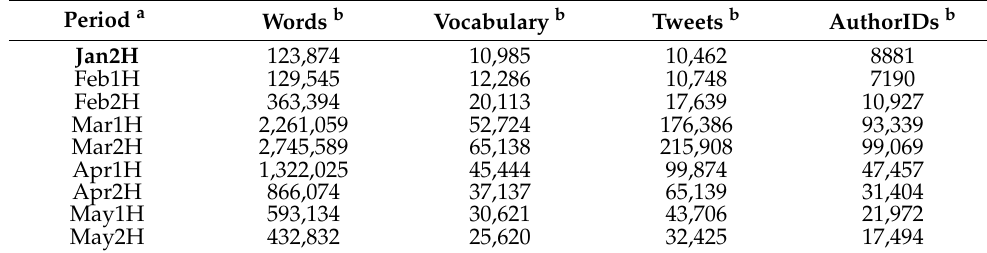
Table 2. Descriptions of corpora by 2-week